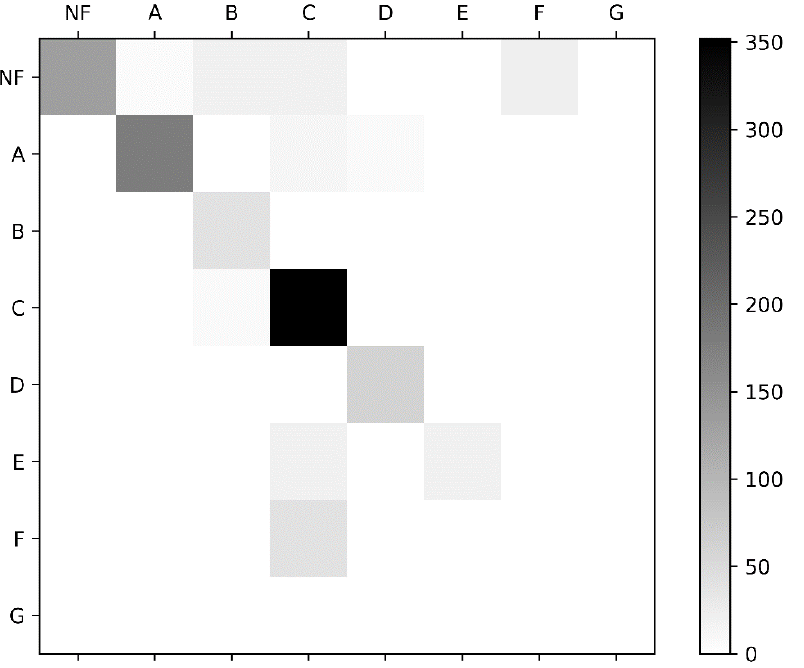
Figure 6. Confusion matrix for results of the best performing model on the real-world dataset.